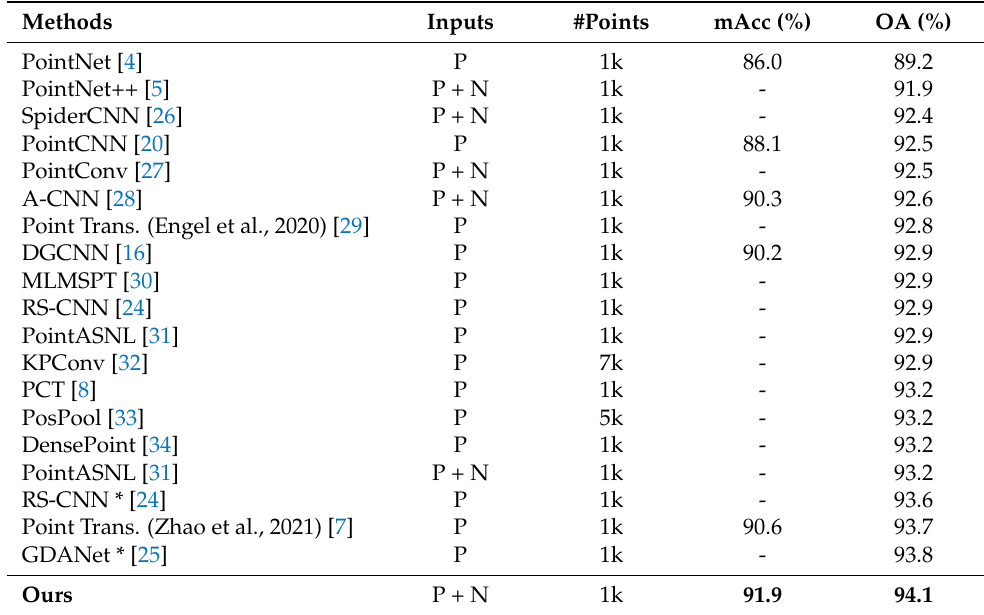
Table 1. Results on the ModelNet40 shape classification. The evaluation metrics are the mean accuracy within each category (mAcc) and the overall accuracy (OA) over all classes (P: point, N: normal, “*”: voting, “-”: unknown). The bolded text indicates the best results.